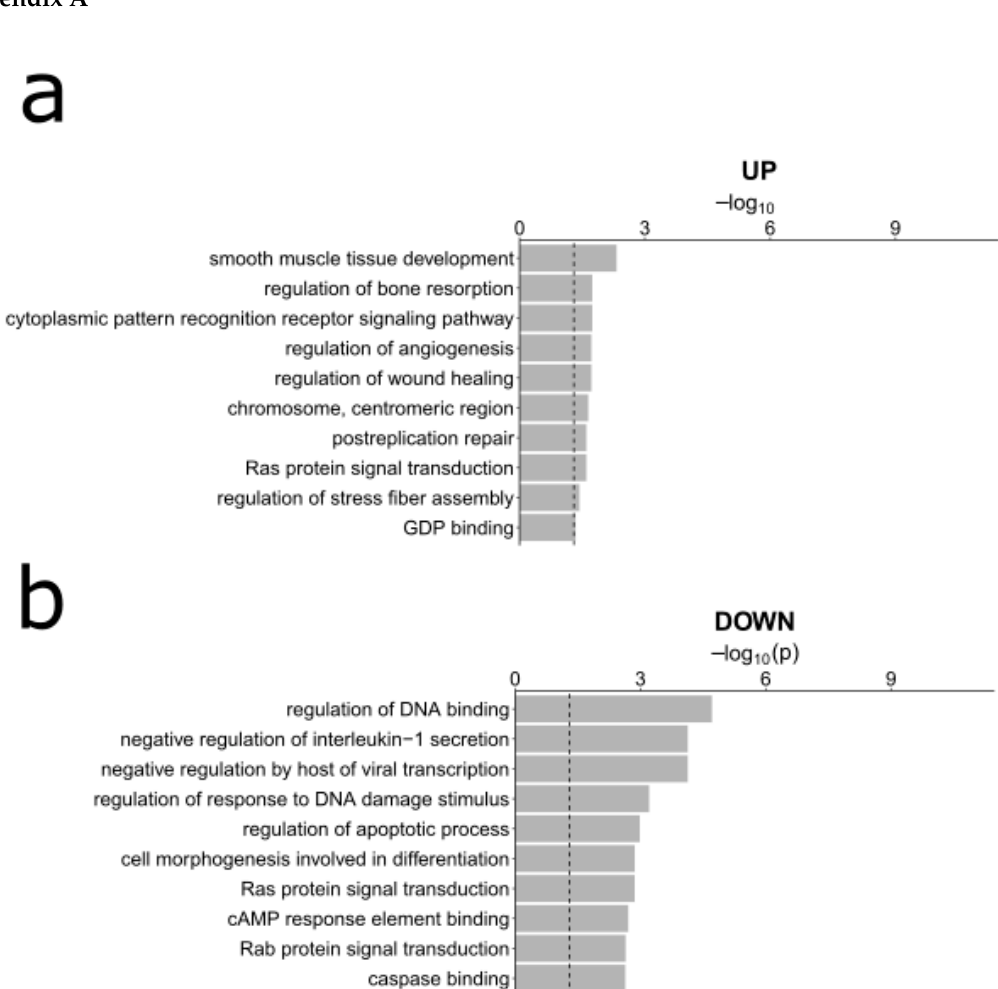
Figure A2. Comparison of AL133346.1 and CCN2 expression between different karyotypes of pediatric B ‐ ALL patients from our own microarray ( a ) and different subtypes of pediatric B ‐ ALL patients from TARGET ( b ) . The boxplots are colored according to the ALL subtype. The BCR ‐ ABL and MLL subtypes had 3 and 0 positive samples respectively, thus they were excluded from the boxplot. Sample sizes: [TCF3 ‐ PBX1]: 7; Trisomy 4–10: 10; [ETV6 ‐ RUNX1]: 10.